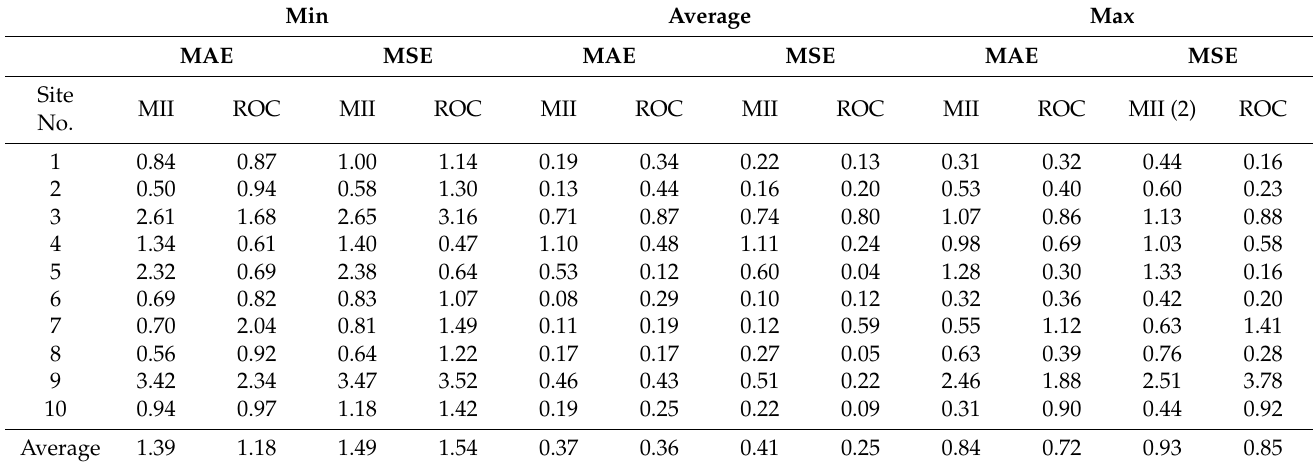
Table 5. Comparison of the best results from Methods I and II and IDW ( ◦ C).